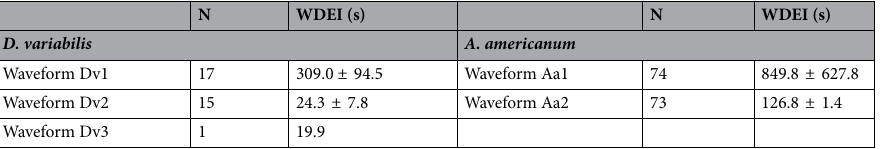
Table 2. Waveform duration per event per insect (WDEI) means ± standard errors (in sec) during early, slow- phase feeding of adult, female D. variabilis and A. americanum . N number of events.